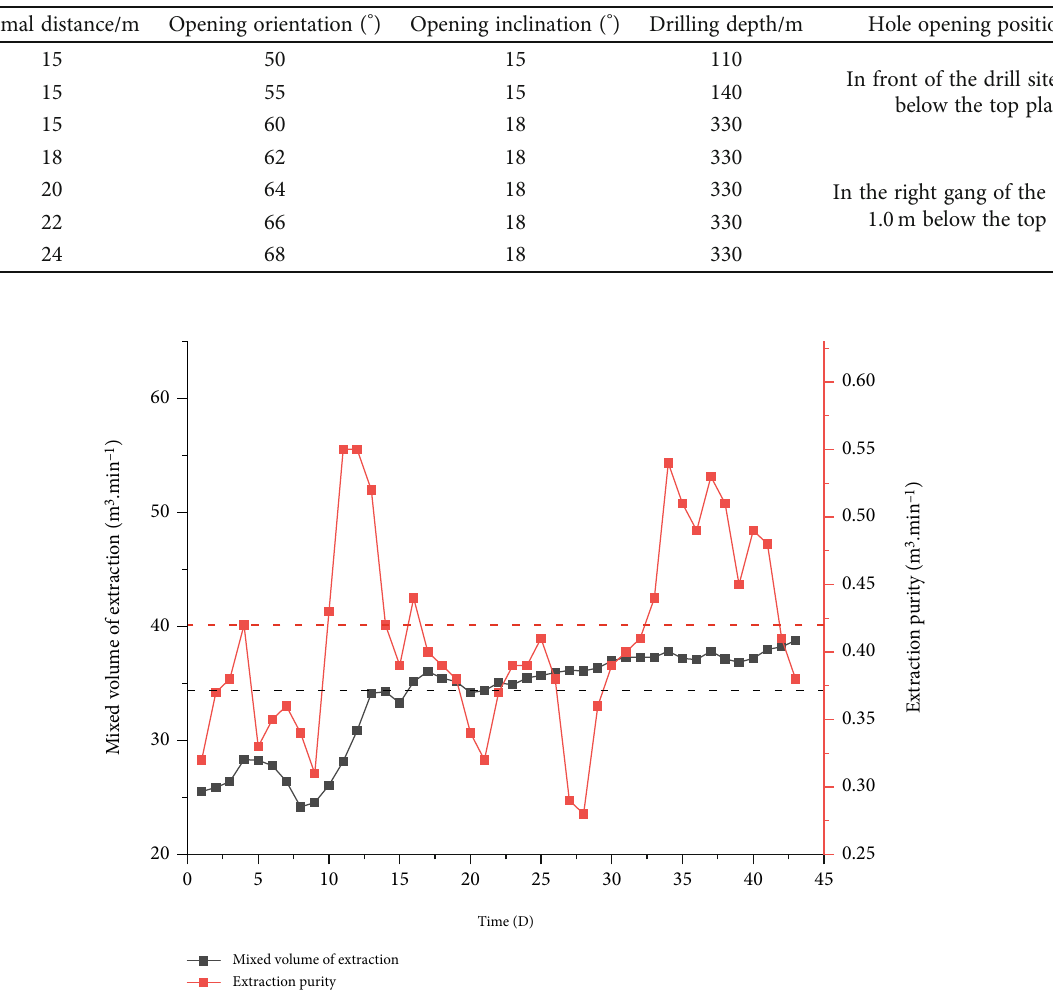
Figure 9: Change trend of gas drainage